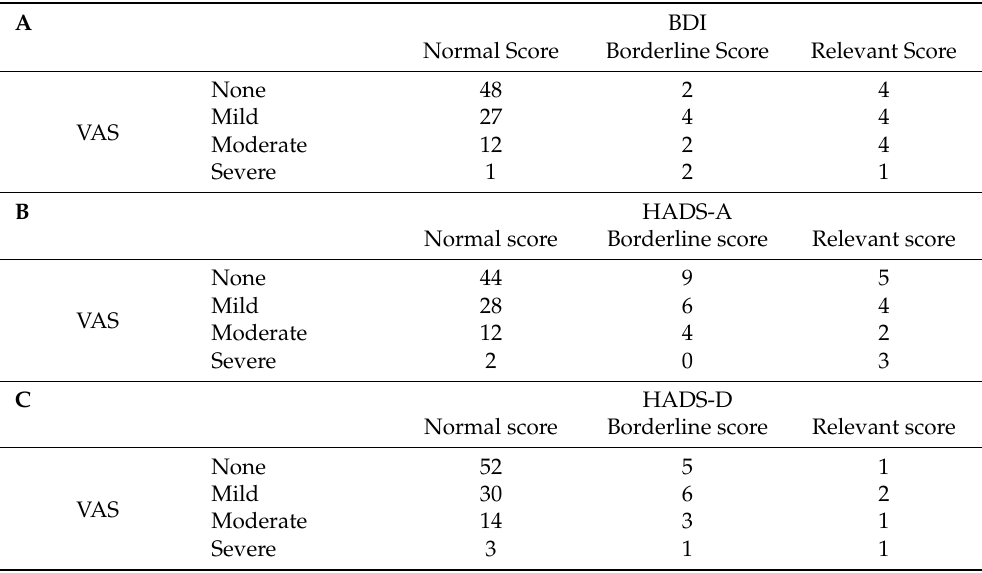
Table 6. Contingency tables for the associations between VAS/BDI (A, p = 0.019), VAS/HADS-A (B, p = 0.18), and VAS/HADS-D (C, p = 0.22); p -values are based on Fisher’s exact